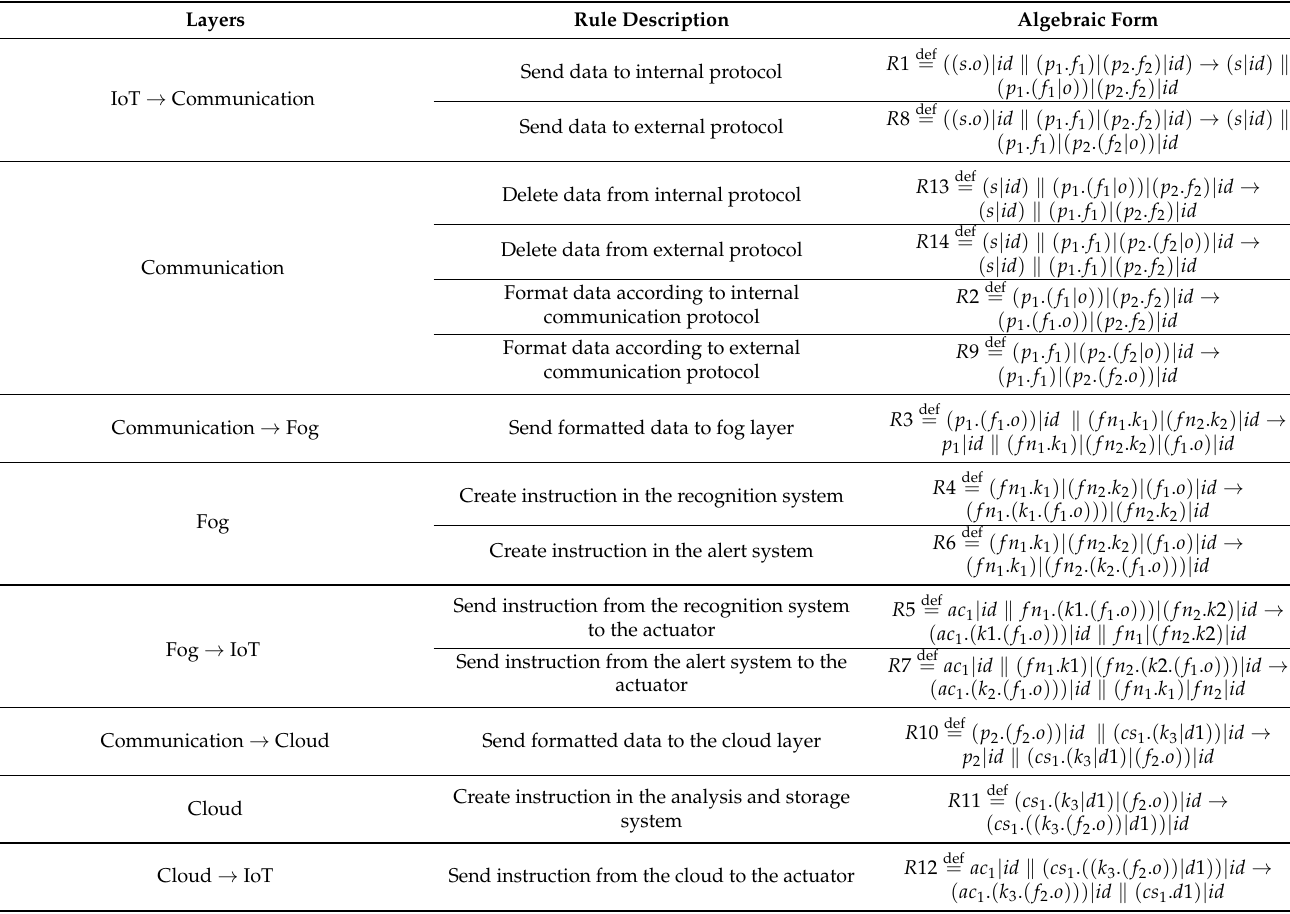
Table 5. Reaction rules of B F associated to